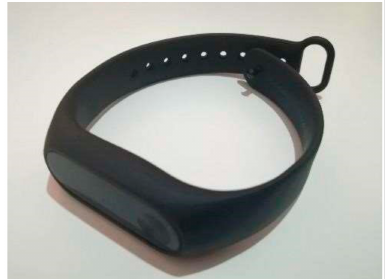
Figure 6. Xiaomi Mi Band